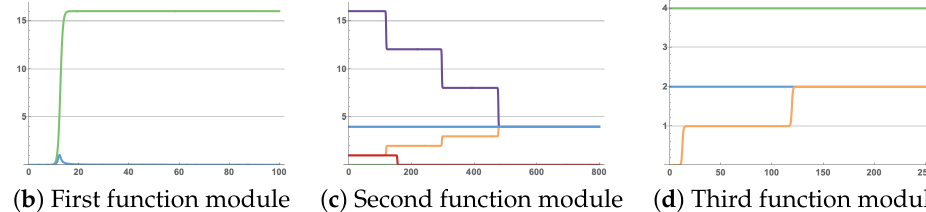
√ √ ∆ , ∆ = 11.0318 (green); ( b ) solution